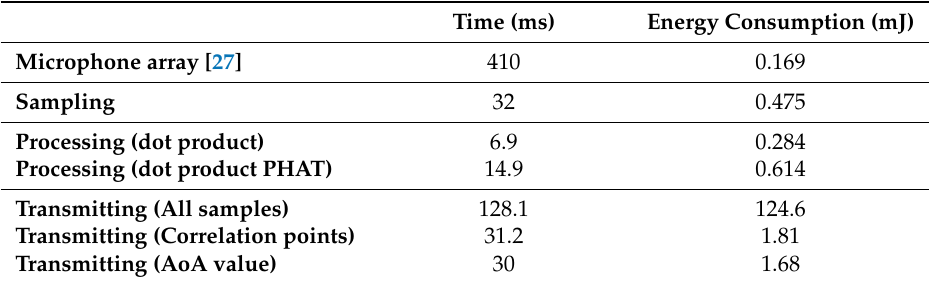
Table 1. The time and energy consumption of each step in the localization process of one event on the EFM32